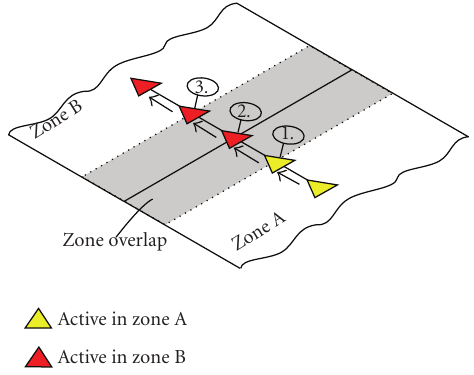
Figure 15: Overlapping zones for a seamless migration of an entity between two